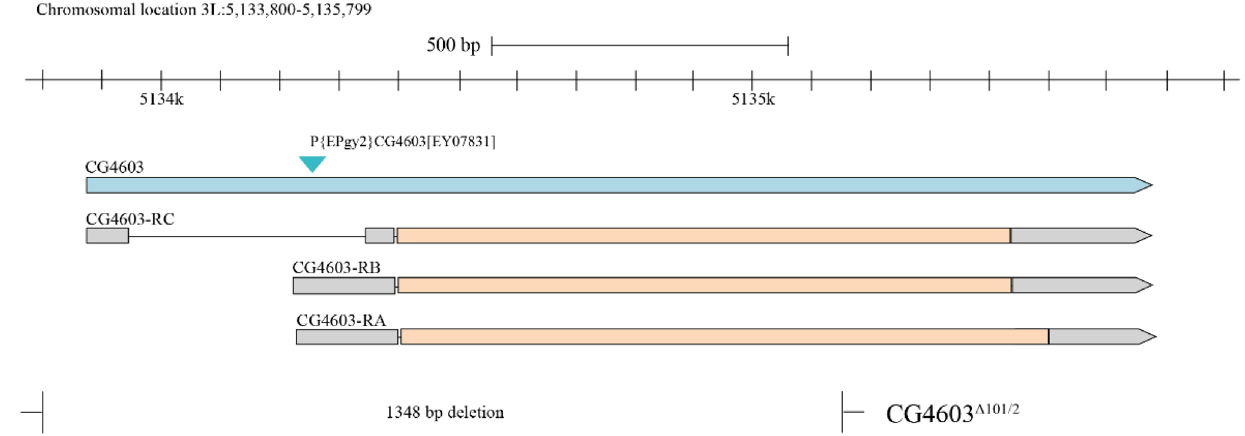
Figure 4. Schematic representation of CG4603 P element insertion and CG4603 Δ101/2 deletion allele. The blue triangle represents the P element insertion, and the broken line shows the deleted segment of CG4603 gene. CG4603-RC, CG4603-RB, and CG4603-RA are the transcripts of CG4603. Figure was prepared on the basis of the FlyBase Genome